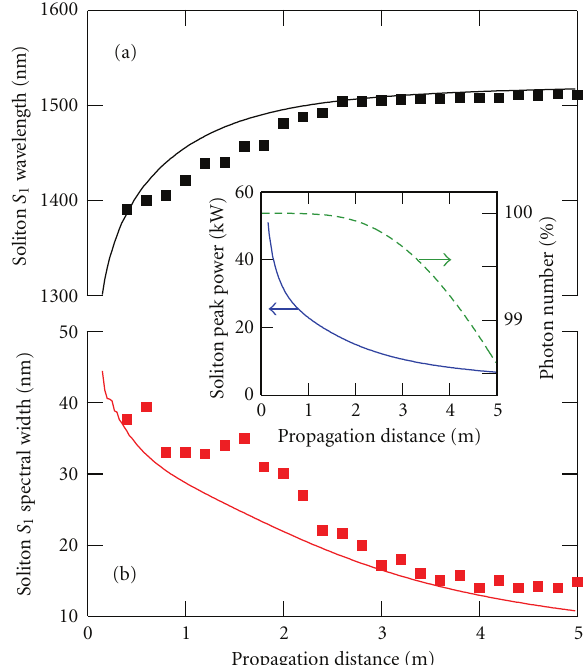
Figure 5: (a) Central wavelength of the first ejected soliton S 1 as a function of propagation distance. (b) Evolution of the soliton S 1 spectral width as a function of propagation distance. Solid lines and markers, respectively, correspond to numerical simulations and experimental measurements. Inset: numerical simulation of soliton S 1 peak power (blue solid line, left axis) and of the total photon number (green dashed line, right axis) versus propagation